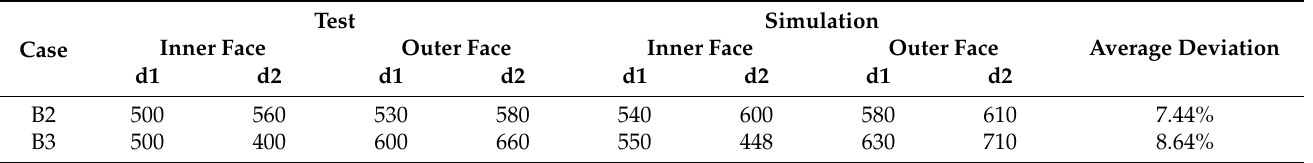
Table 9. Size of punching failure zone (unit: mm).